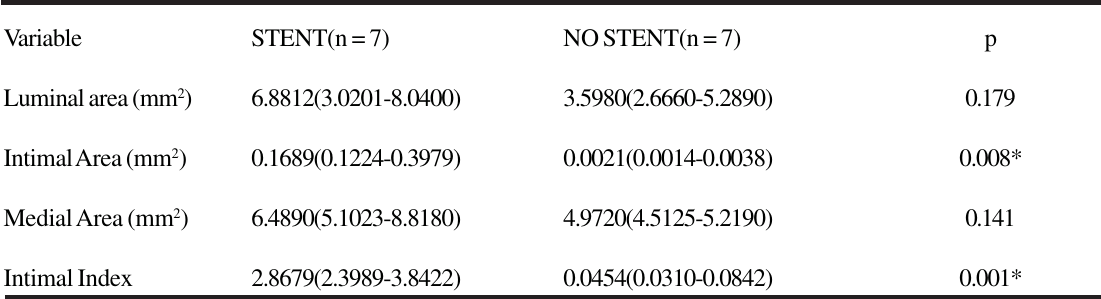
TABLE 1 - Morphometric analysis of areas in the STENT and NO STENT groups